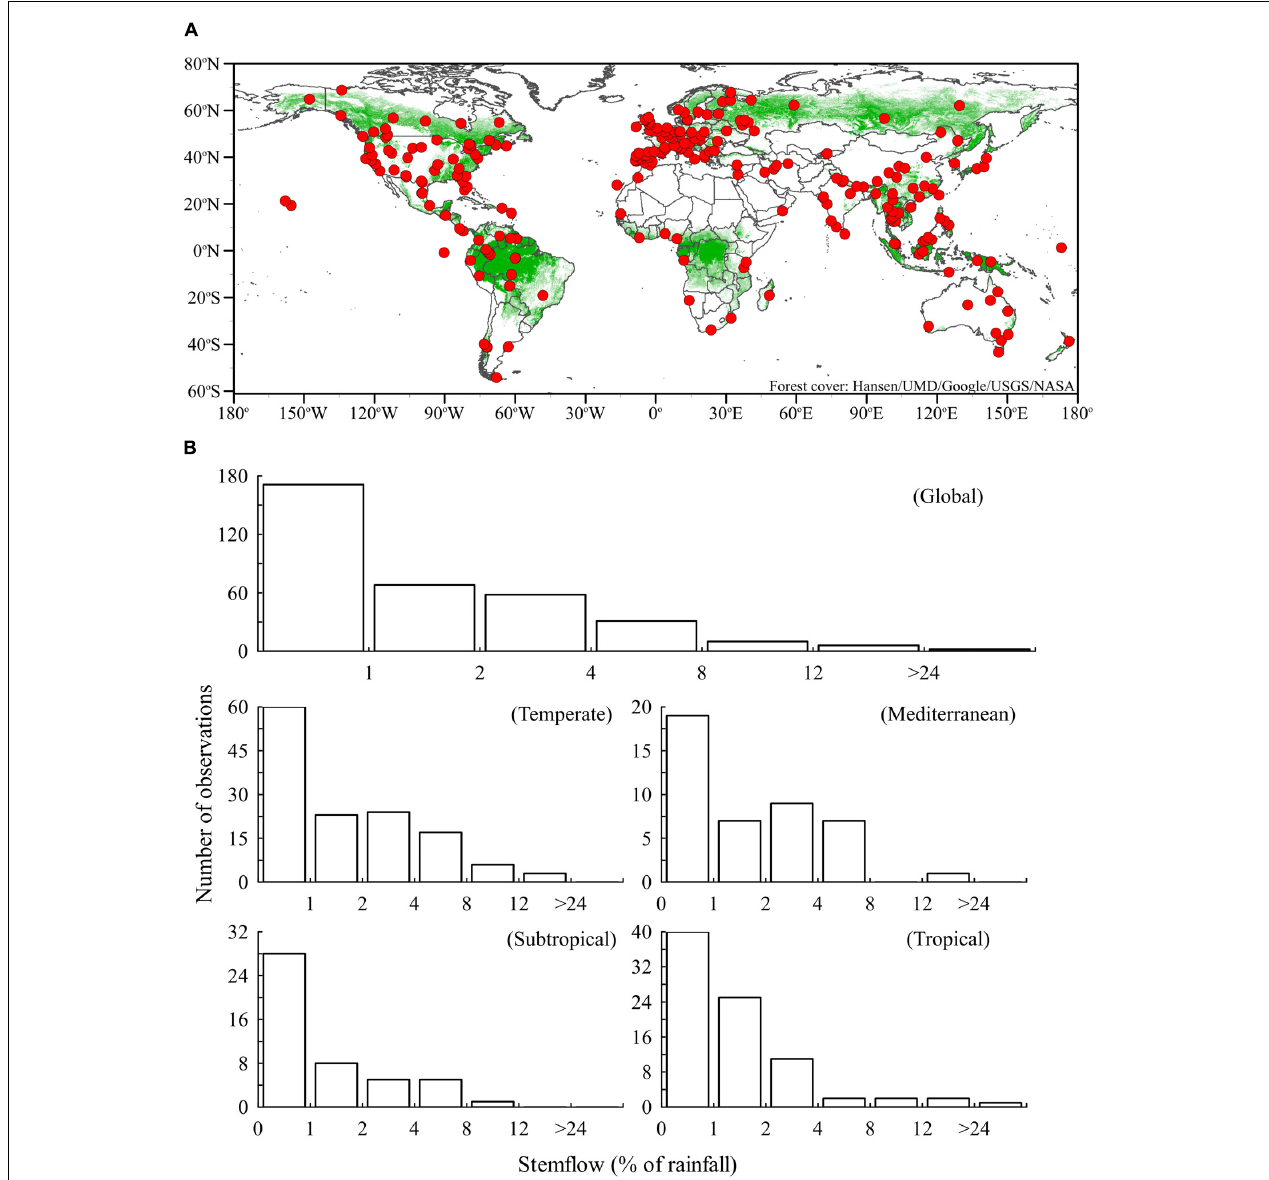
FIGURE 1 | (A) Locations around the globe (Supplementary Table S1) where stemflow has been measured are well-distributed throughout the Earth’s forests. (B) Histograms of stemflow (% rainfall) from studies reporting on 346 tree species or forest types (Supplementary Table S2). Studies that simply report “negligible” stemflow have been placed in the < 1% category in the